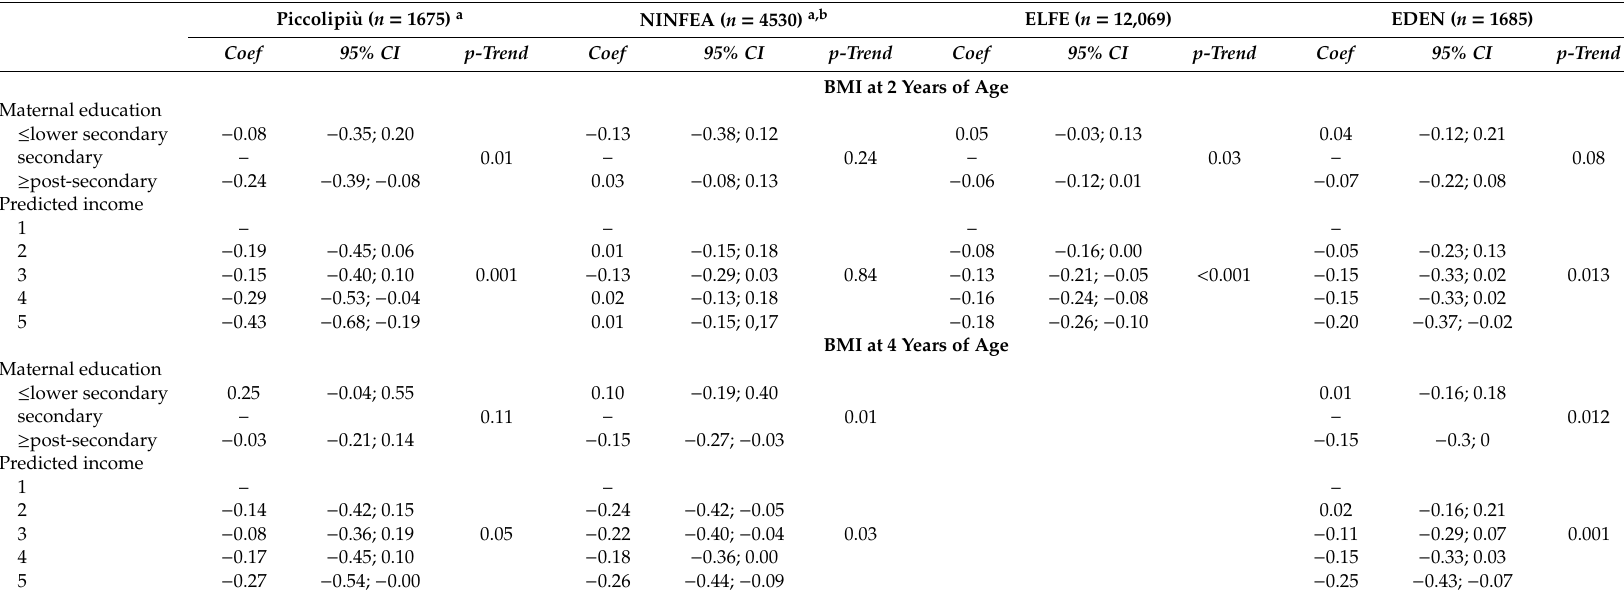
Table 2. Associations between predicted income (quintiles) and child BMI at 2 and 4 years of age by cohort. Piccolipi ù ( n = 1675)